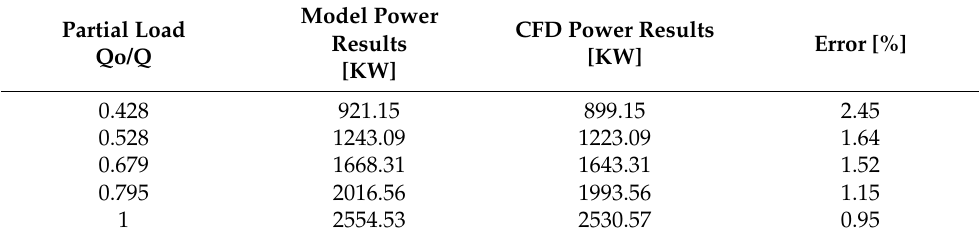
Table 6. Theorical and Numerical comparison results.